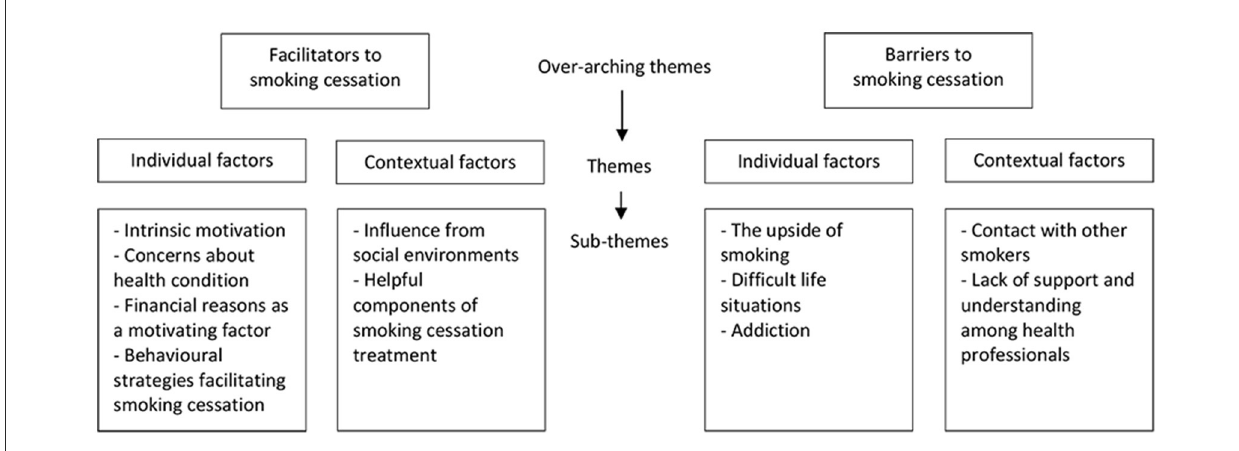
FIGURE1 Overview of themes and sub-themes developed in the thematic